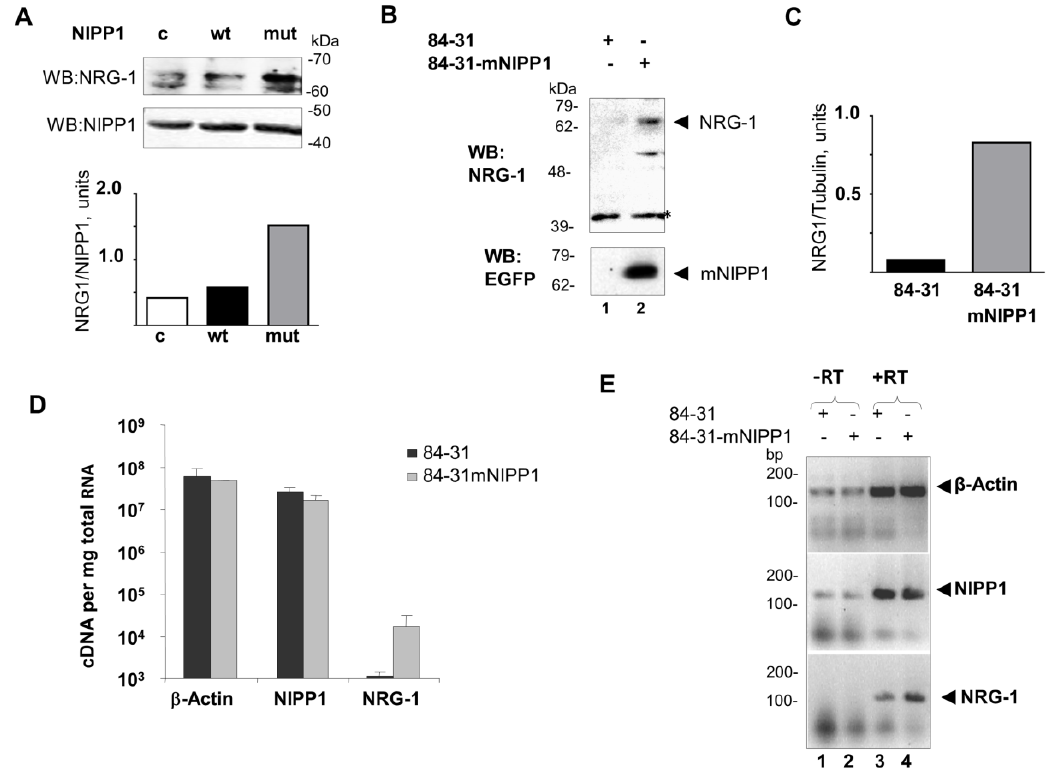
Figure 2. Expression of mutant NIPP1 (mNIPP1) induces NRG-1 expression. ( A ) Transient expression of mNIPP1 increases the protein level of NRG-1. HEK293T cells were transfected with either NIPP1-EGFP or mNIPP1-EGFP expression vectors. Lysates were collected 48 hours after transfection, resolved on 7.5% SDS-PAGE gel and analyzed by Western blot using anti-NRG-1 and anti- EGFP antibodies. Lower panel shows quantification; ( B , C ) Stable expression of mNIPP1 increases the protein level of NRG-1. Lysates from 84-31 cells and 84-31-mNIPP1 cells were resolved on 7.5% SDS-PAGE and analyzed by Western blot with anti-NRG-1 and anti-EGFP antibodies. An asterisk indicates the position of the non-specific protein band serving as a loading control. Panel C shows quantification of the results from panel B; ( D ) Quantitative RT-PCR (qPCR) analysis of NRG-1 expression. Total RNA was isolated from 84-31 cells and from 84-31-mNIPP1 cells, reverse transcribed and amplified with primers for β-actin, NIPP1 and NRG-1 as described in Experimental Procedures using SYBR green. Ct values obtained were recalculated to the number of cDNA copies per mg of total RNA. Mean and SD are shown; ( E ) Analysis of the quantitative RT-PCR products on agarose gel. PCR amplified cDNA was resolved on 2% agarose gel and visualized with ethidium bromide staining. Lanes 1 and 2, non-transcribed RNA; and lanes 3 and 4, reverse-transcribed RNA from 84-31 and 84-31 mNIPP1 cells amplified with primers for β-actin, NIPP1 or NRG-1 as indicated.